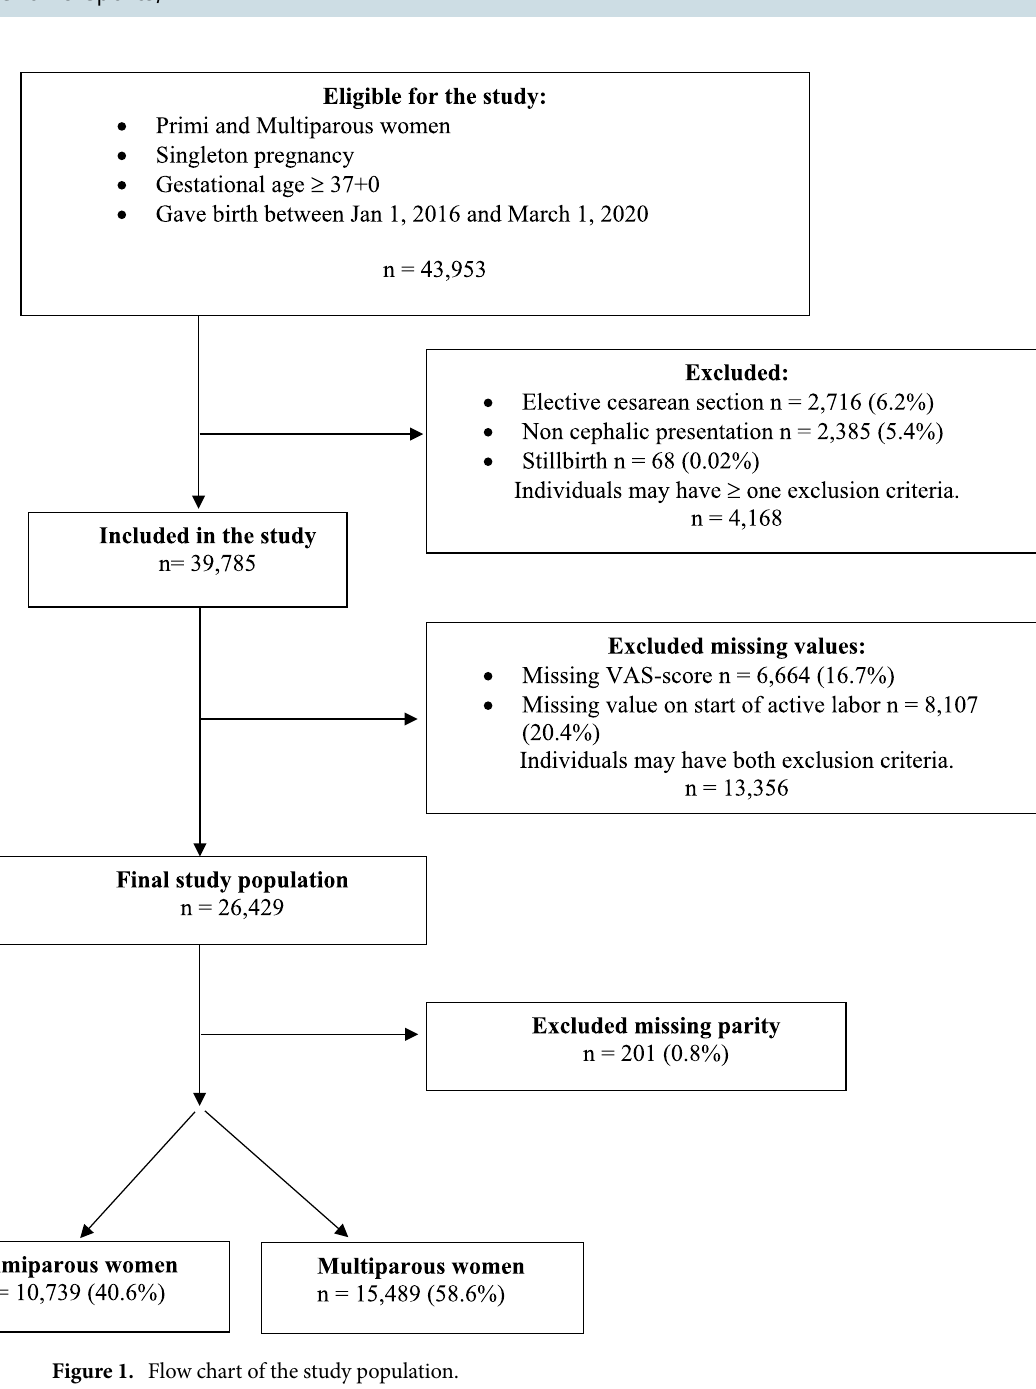
Figure 1. Flow chart of the study